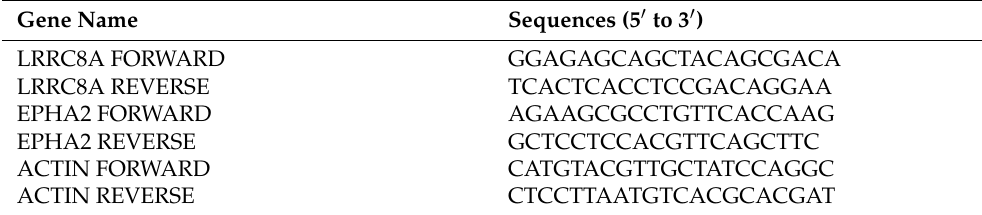
Table 1. Primer sequences for Real-time